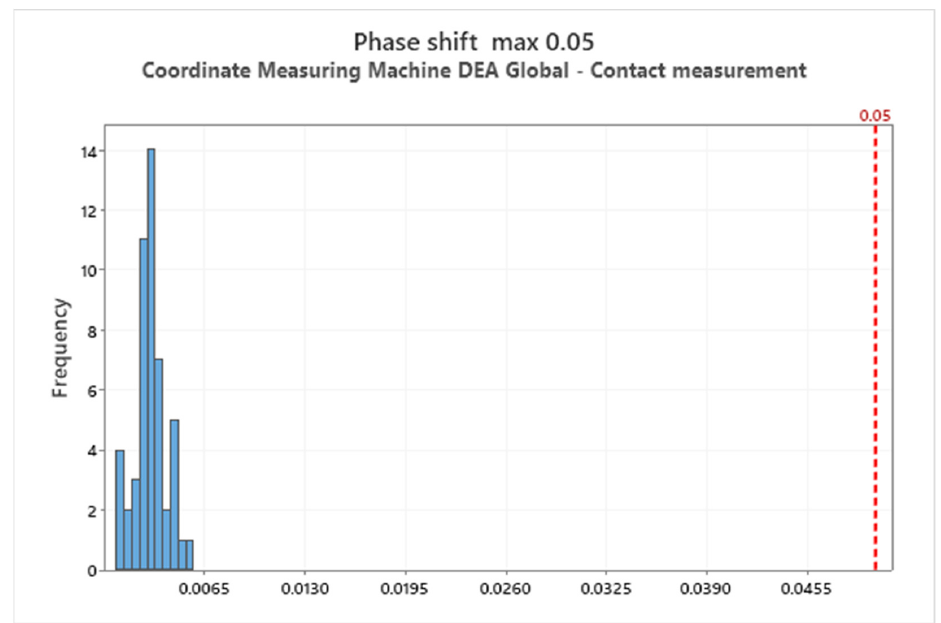
Figure 14. Phase shift of the teeth max. 0.05—histogram from measurements obtained with the LH- 600 height gauge, values on x axis given in mm (own study).